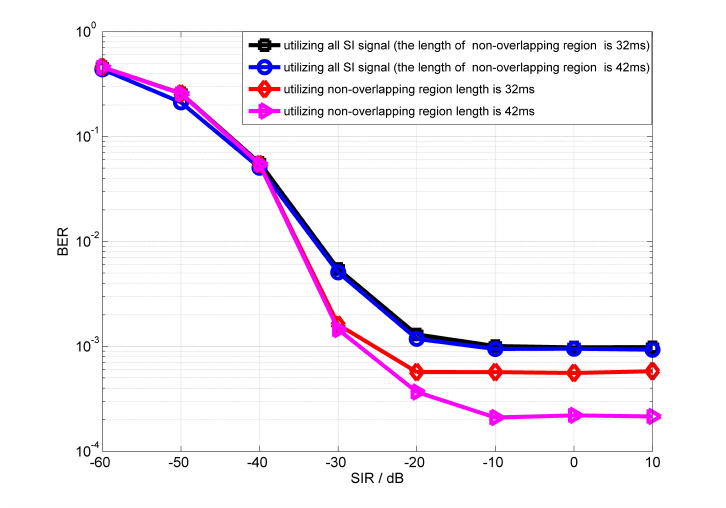
Figure 8. BER performance of OPRLS utilizing non-overlapping region versus